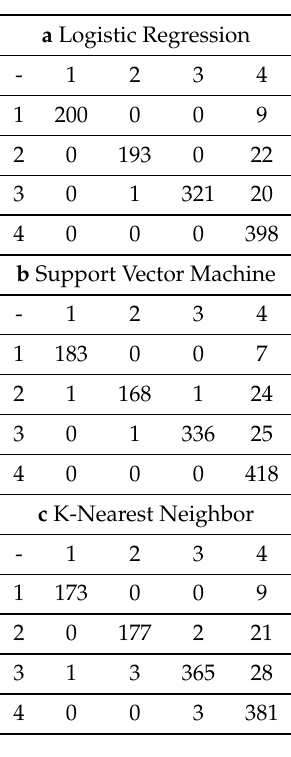
Table 14. Confusion matrices of different machine learning methods for three